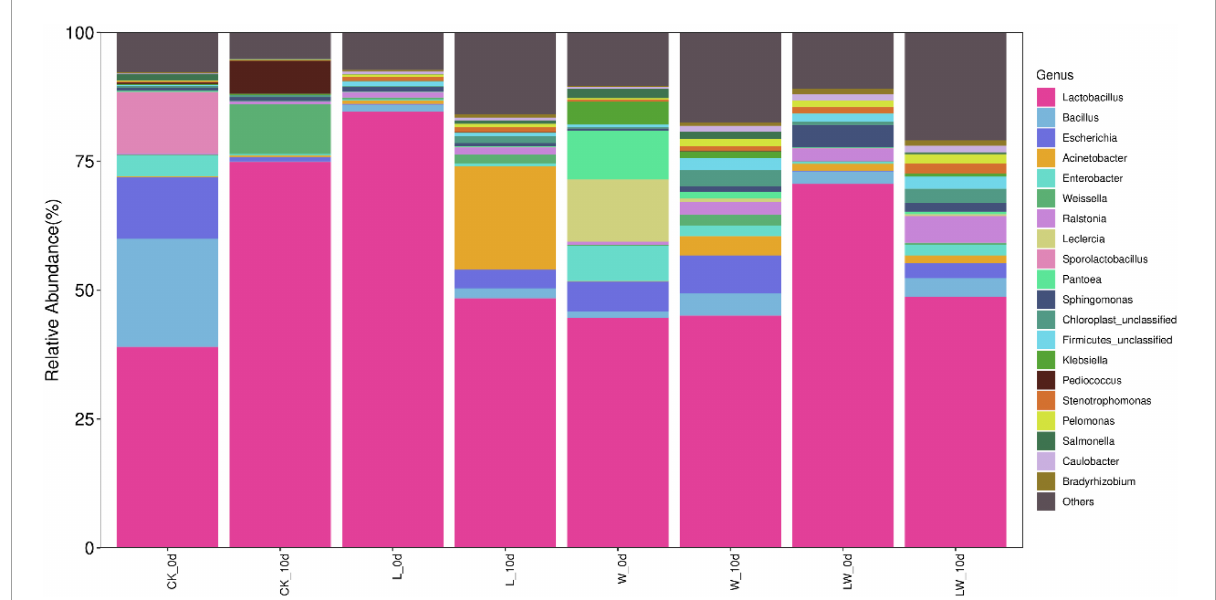
FIGURE3 The relative abundance of bacterial community (genus level) in Leymus chinensis silages at 0 and 10 days of opening ( n = 3). CK, ensiling L. chinensis with 2.00 ml/kg fresh weight (FW) of distilled water; L, ensiling L. chinensis with 2.00 g/t FW of lactic acid bacteria (LAB) inoculant and 2.00 ml/kg FW of distilled water; W, ensiling L. chinensis with 100 ml/kg FW of distilled water; LW, ensiling L. chinensis with 2.00 g/t FW of LAB inoculant and 100.0 ml/kg FW of distilled